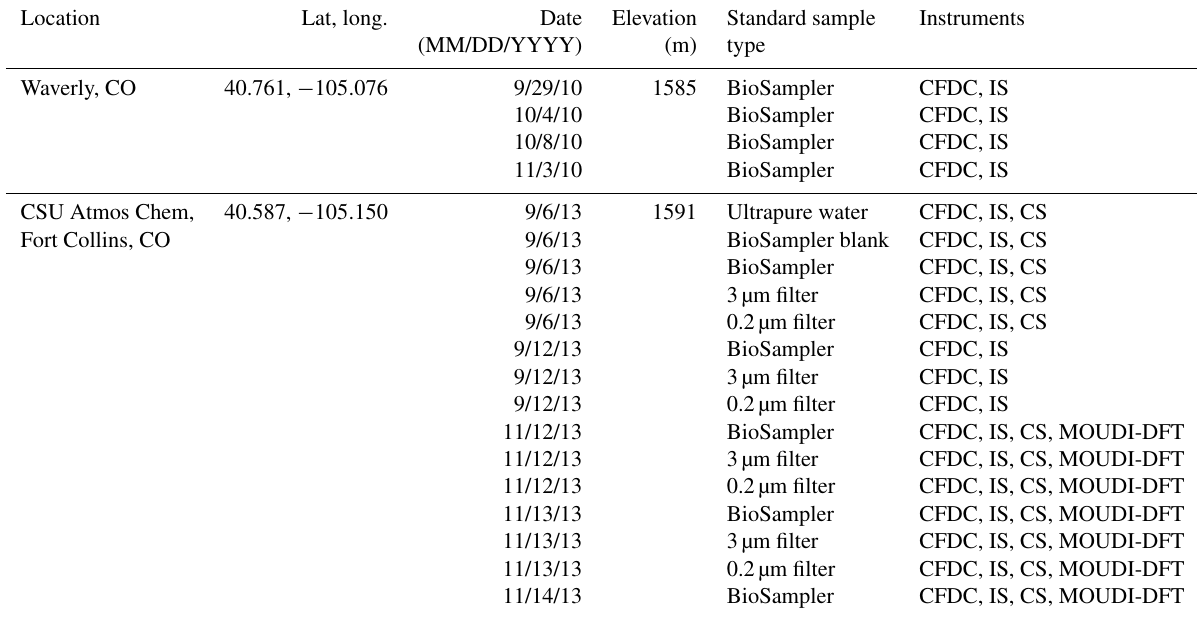
Table 1. Samples taken during periods when the CFDC was operated at a single temperature on each date and when immersion freezing methods were aligned in time, sharing samples in some cases. Data from Waverly, CO, are from Garcia et al. (2012). Sample volumes ranged from 1600 to